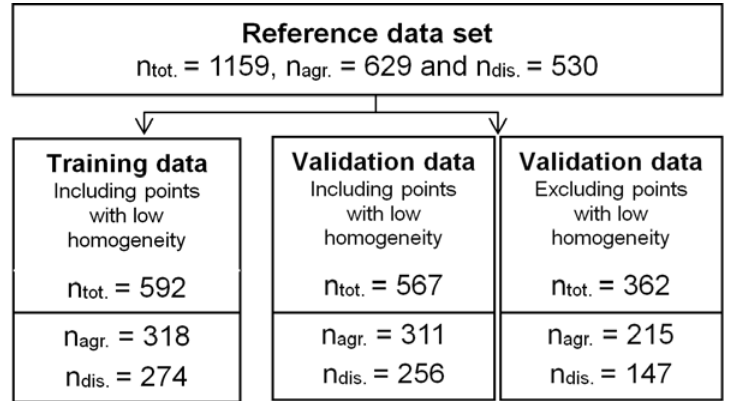
Figure 7. The reference dataset was divided into training and validation subset. The total number of points and the corresponding agreement (‘agr’) and disagreement (‘dis’) are provided for each subset. The accuracy assessment stage distinguished between two validation datasets; one including the points with low homogeneity and one excluding these